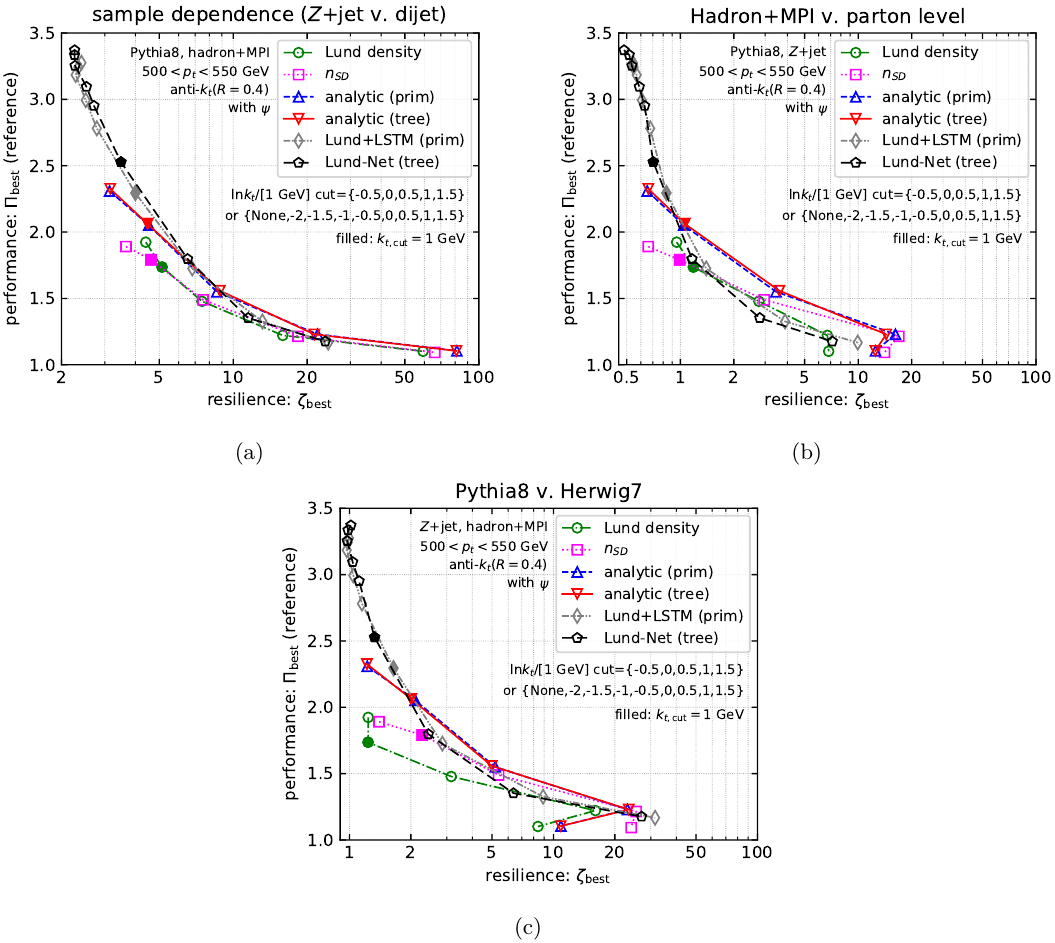
Figure 8. Plots of performance as a function of resilience for different discriminants. The curves are obtained by scanning over a range of accessible k values. The filled symbols correspond to t, cut a k cut of 1 GeV. Different plots correspond to different probes of resilience: (a) probes the sample t dependence (replacing the Z +jet sample with a dijet sample, (b) probes non-perturbative effects (using parton-level simulations instead of full simulations with hadronisation and multi-parton inter- actions) and (c) probes the effect of the Monte Carlo generator (using Herwig 7 instead of Pythia